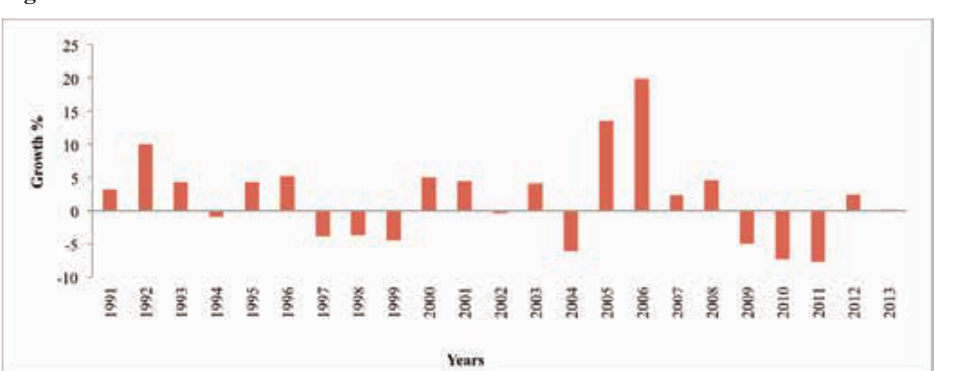
Figure 8: Trend of Investment Growth in